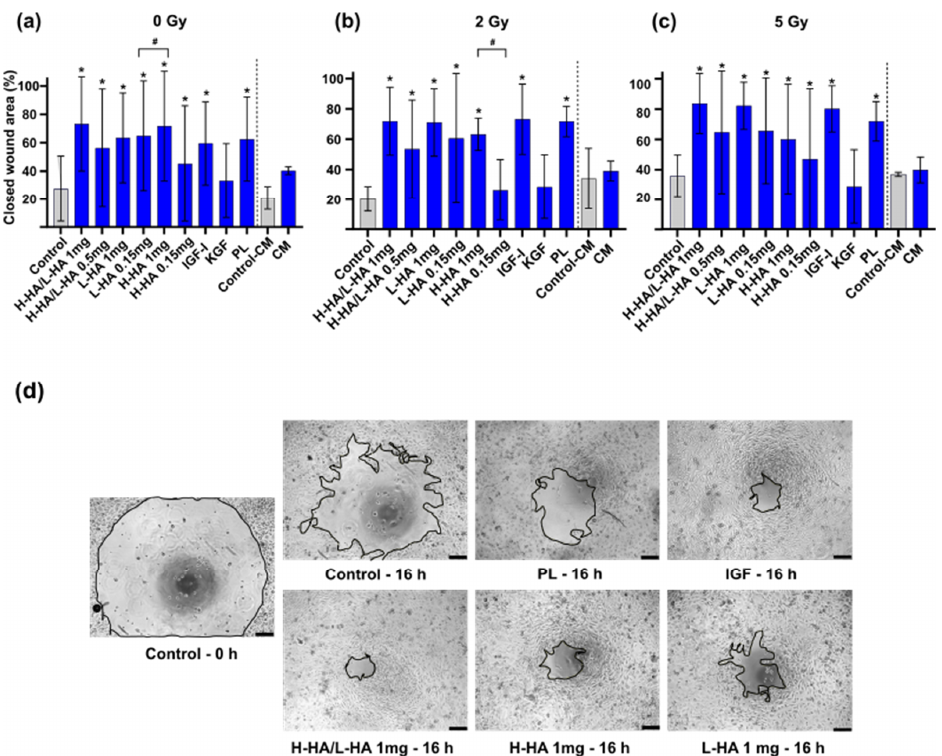
Figure 4. Keratinocyte migration of the irradiation groups 0, 2, and 5 Gy with growth factors after 16 h: ( a ) Y-axis shows closed wound area without irradiation ; ( b ) Y-axis shows closed wound area after 2 Gy irradiation ; ( c ) Y-axis shows closed wound area after 5 Gy irradiation ; ( d ) representative images of irradiated keratinocytes at time point 0 h and 16 h. p ≤ 0.05, significances were correlated to the respective control. * = significant compared to the control without growth factors in the re- spective irradiation dose at the respective time point. # = significant compared to the lower dose of HA. Scale bar 200 µm.